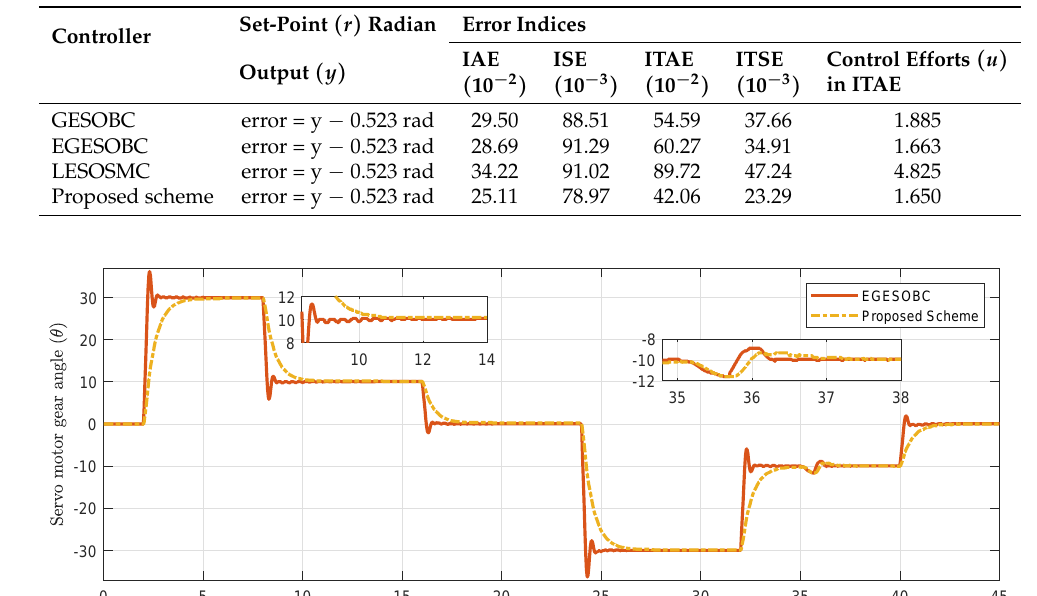
Figure 14. Simulation result of error dynamics. Table 4. Comparison of performance indices for simulation results of SLFM.